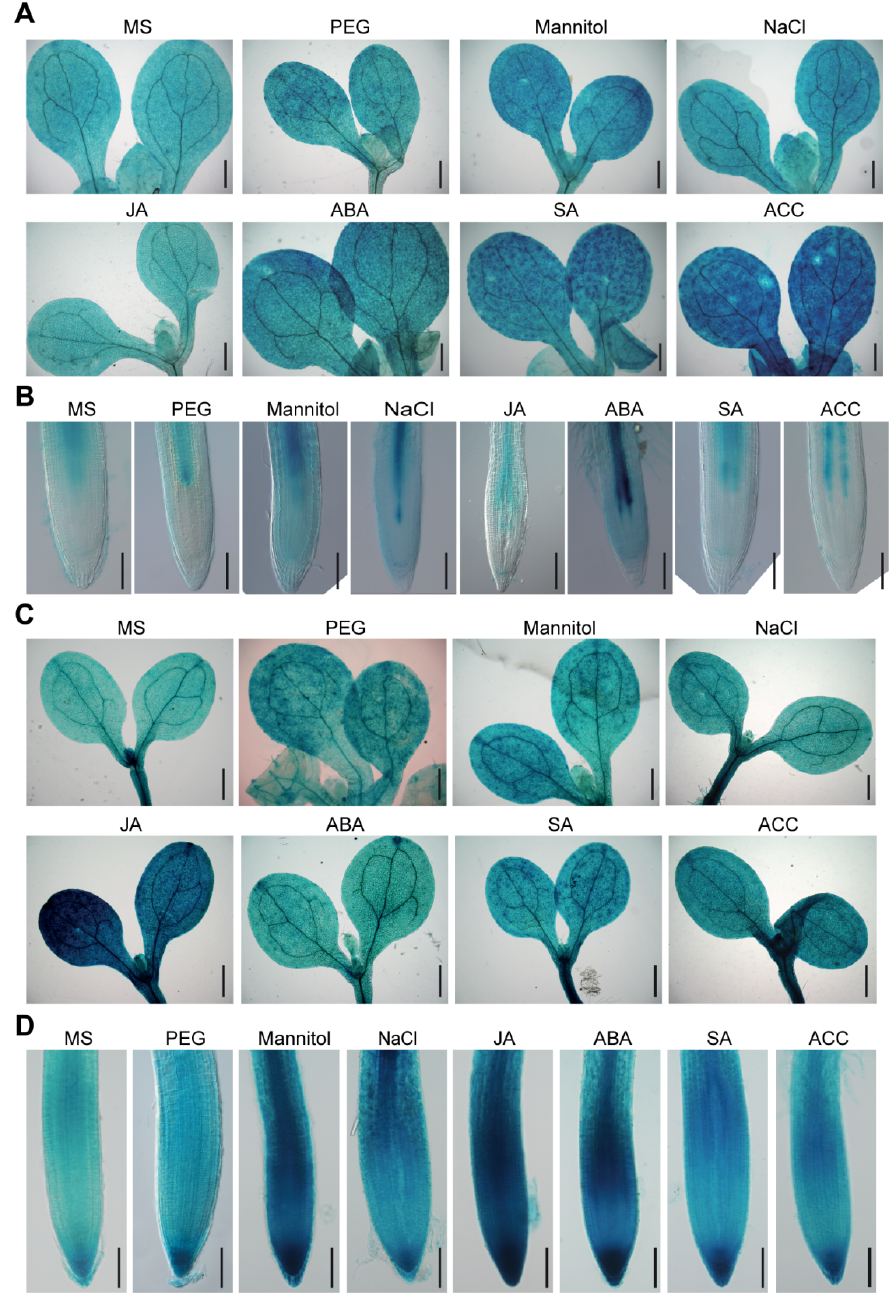
Figure 2. Expression of ProBAG2:GUS and ProBAG6:GUS in response to various abiotic stresses and hormones. Five-day-old ProBAG2:GUS ( A , B ) and ProBAG6:GUS (c and d) seedlings were transferred to Murashige and Skoog (MS) media (mock) supplemented with 5% PEG, 300 mM mannitol, 200 mM for GUS staining. Shown are representative images of shoots ( A , C ) and root tips ( B , D ) of three independent experiments. Bars = 400 µ m in ( A , C ) and 100 µ m in ( B , D